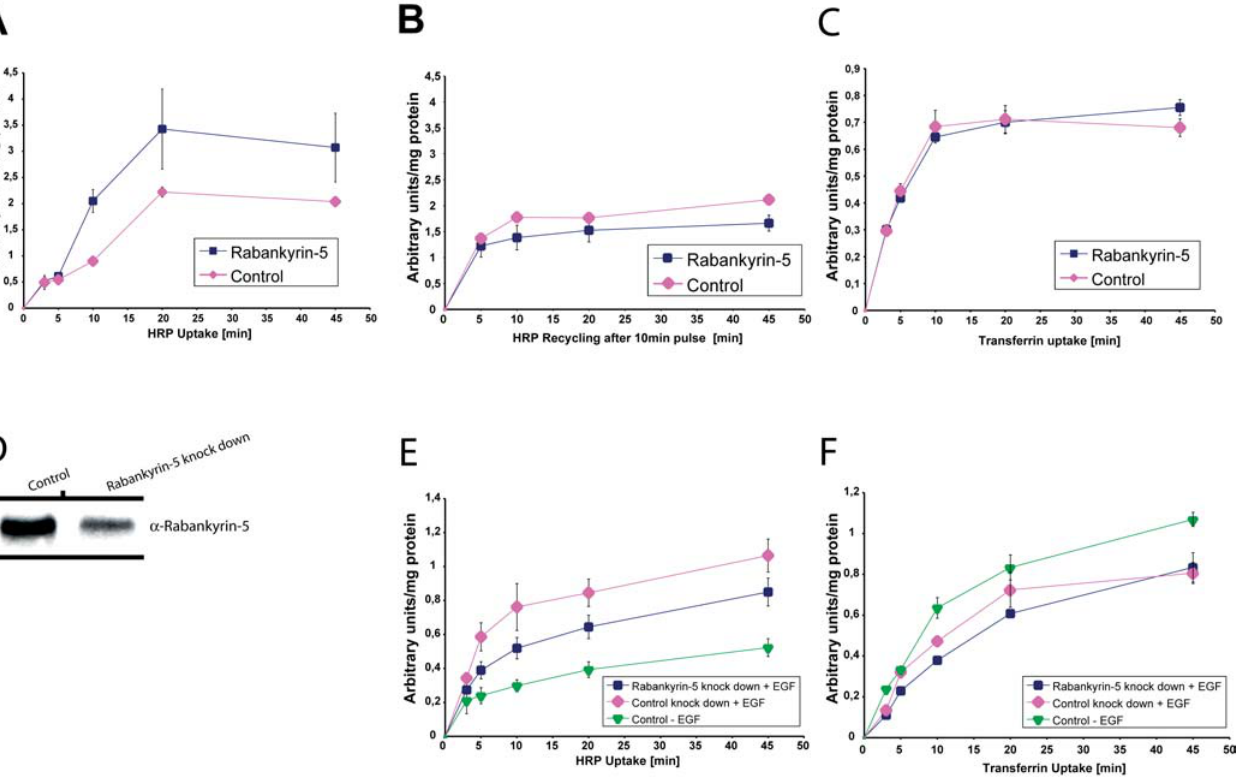
Figure 7. Rabankyrin-5 Overexpression Increases, whereas Knock-Down Decreases Fluid-Phase Uptake, Specifically (A–C) NIH3T3 cells were either mock-infected or infected with recombinant adenovirus encoding Rabankyrin-5. Simultaneous uptake of HRP (5 mg/ml) and biotinylated transferrin (2 l g/ml) was performed at 37 8 C for the indicated time points. (C) NIH3T3 cells were pulsed with HRP (10 mg/ml) for 10 min. Recycled HRP into the medium was determined after the indicated time points. (D–F) A431 cells were treated with esiRNA against Rabankyrin-5 or control treated for 4 d. (D) Western blot analysis revealed a ~50% reduction of Rabankyrin-5 in whole-cell lysate. (E and F) Serum-starved cells (1 h) were stimulated with 50 ng/ml EGF in complete medium for the indicated time points in the presence of 5 mg/ ml HRP and 2 l g/ml biotinylated transferrin. Values shown are means 6 standard deviation and were performed in duplicates. The results are representatives of at least two independent